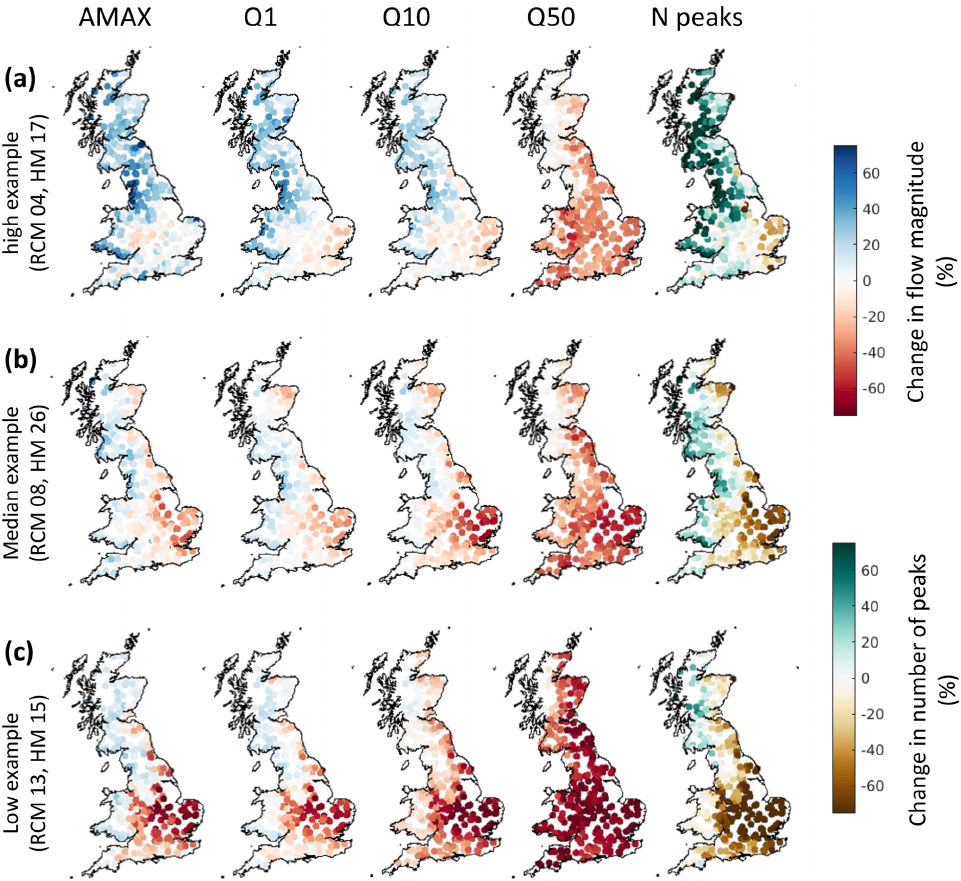
Figure 4. Maps showing changes in the magnitude and frequency of peak flows between the baseline and future periods for example simulations. Each row shows a nationally coherent projection, with plots of changes in five flow metrics (AMAX, Q1, Q10, Q50 and the number of peak flows above a threshold). This combination of RCMs and hydrological parameter sets was selected from the ensemble of 360 simulations to give an indication of the ensemble spread, as they provided the highest, median, and lowest GB-average change in Q10, but they do not show the full range of possible changes for individual catchments or all flow